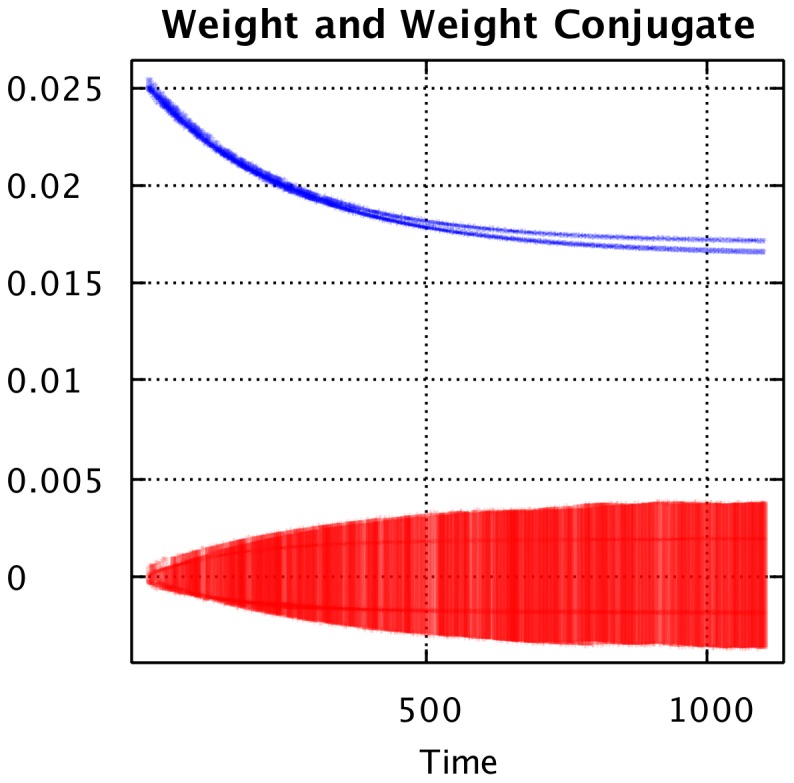
Justification of constant weight conjugate.Multiple AHaH nodes receive spike patterns from the set  while the weight and weight conjugate is measured. Blue = weight conjugate (), Red = weight (). The quantity  has a much lower variance than the quantity  over multiple trials, justifying the assumption that  is a constant factor.